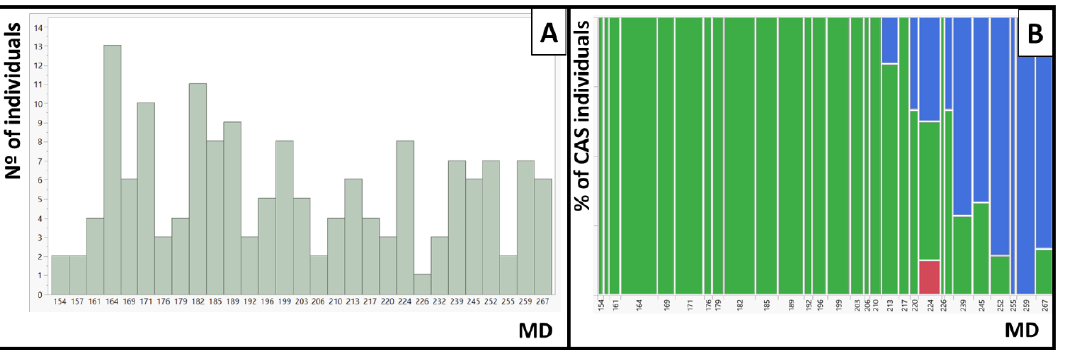
Figure 2. Maturity date (MD) and red color around the stone (CAS) in IRTA’s peach cultivar collec- tion. ( A ) Distribution of the MD in Julian days. ( B ) Contingency table between CAS and MD. In green, percentage of individuals with no CAS, and in blue, percentage of individuals with CAS. In red, the Diablotina cultivar that was not phenotyped for CAS.